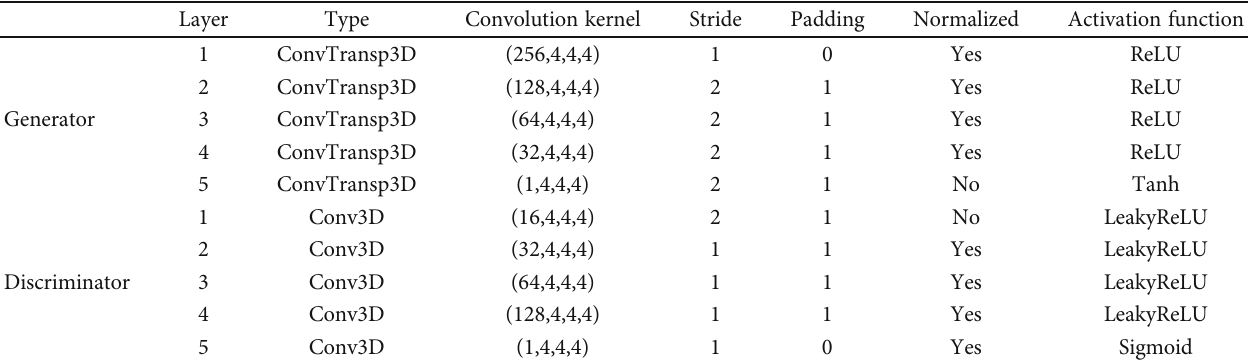
Figure 1: Model structure diagram. Table 1: Network structure parameter